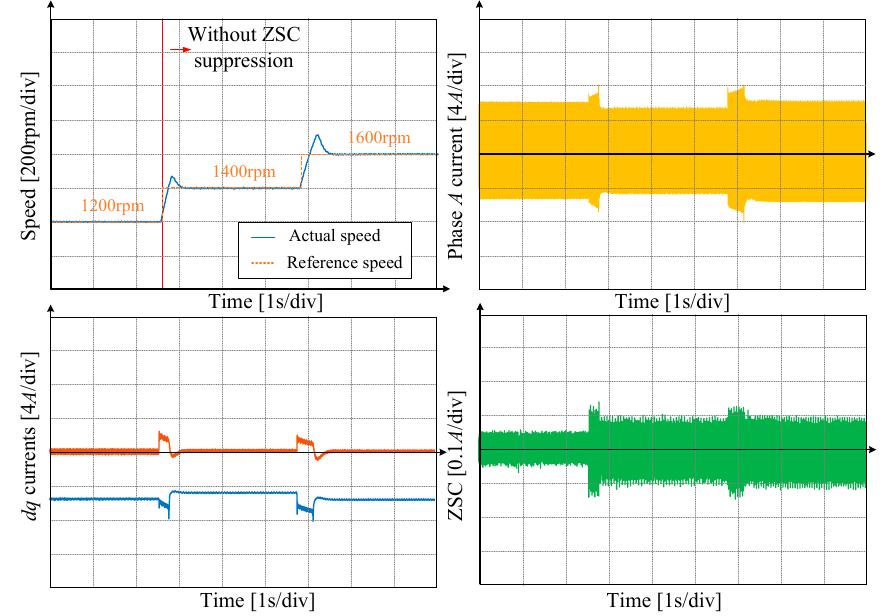
Figure 22. Overmodulation dynamic performance of FW-DFVL under 0.6 Nm. Moreover, the computation burden of two controllers is compared in the utilized space. The execution time of the conventional flux-weakening controller is 28.2 µ s, and the execution time of FW-DFVL is 32.4 µ s. The increase in the execution time is mainly caused by the gradient descent